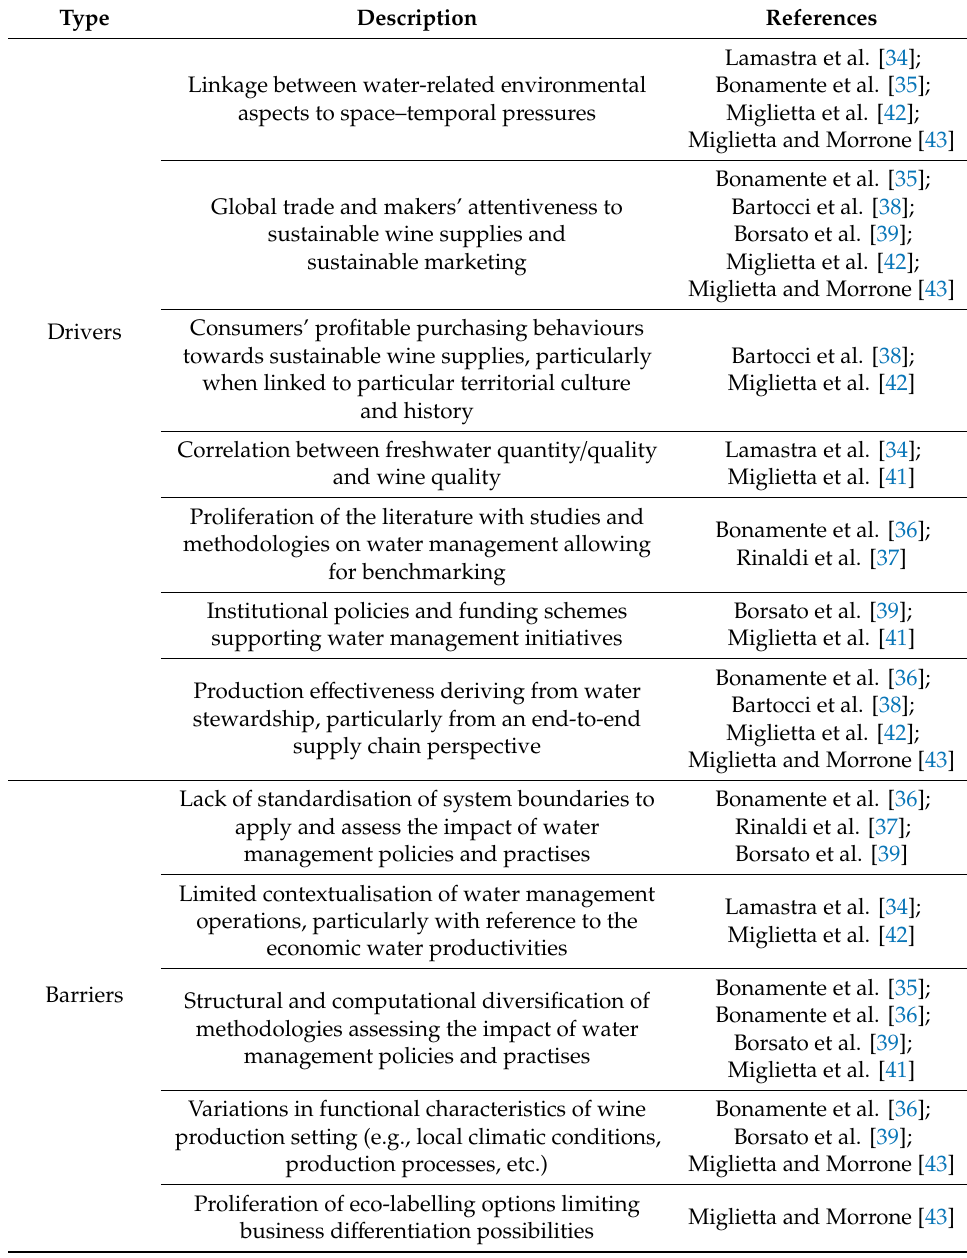
Table 2. Drivers and barriers of water stewardship in